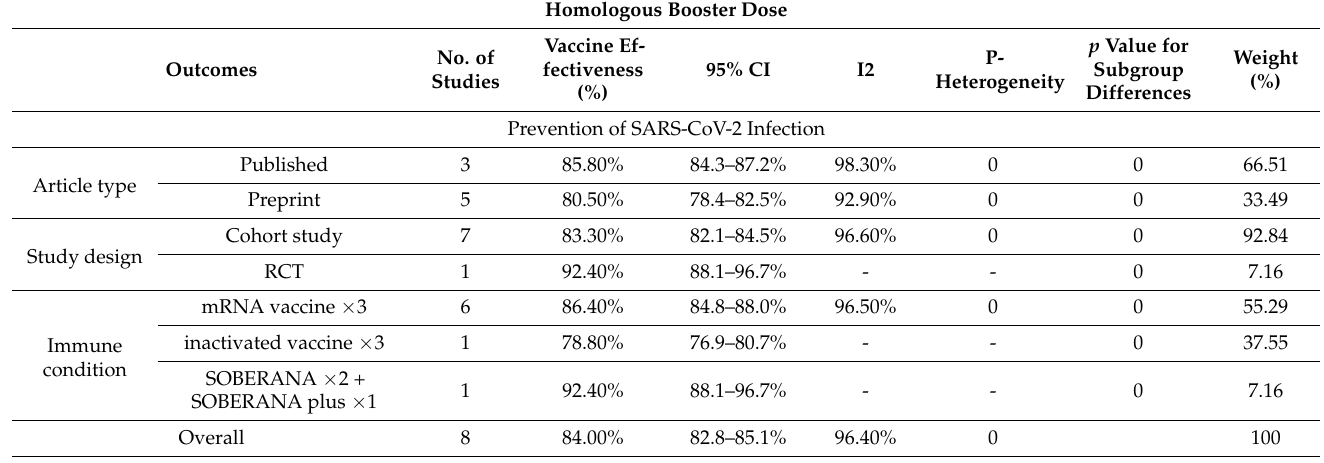
Table 3. Comparison of effectiveness between heterologous booster and homologous